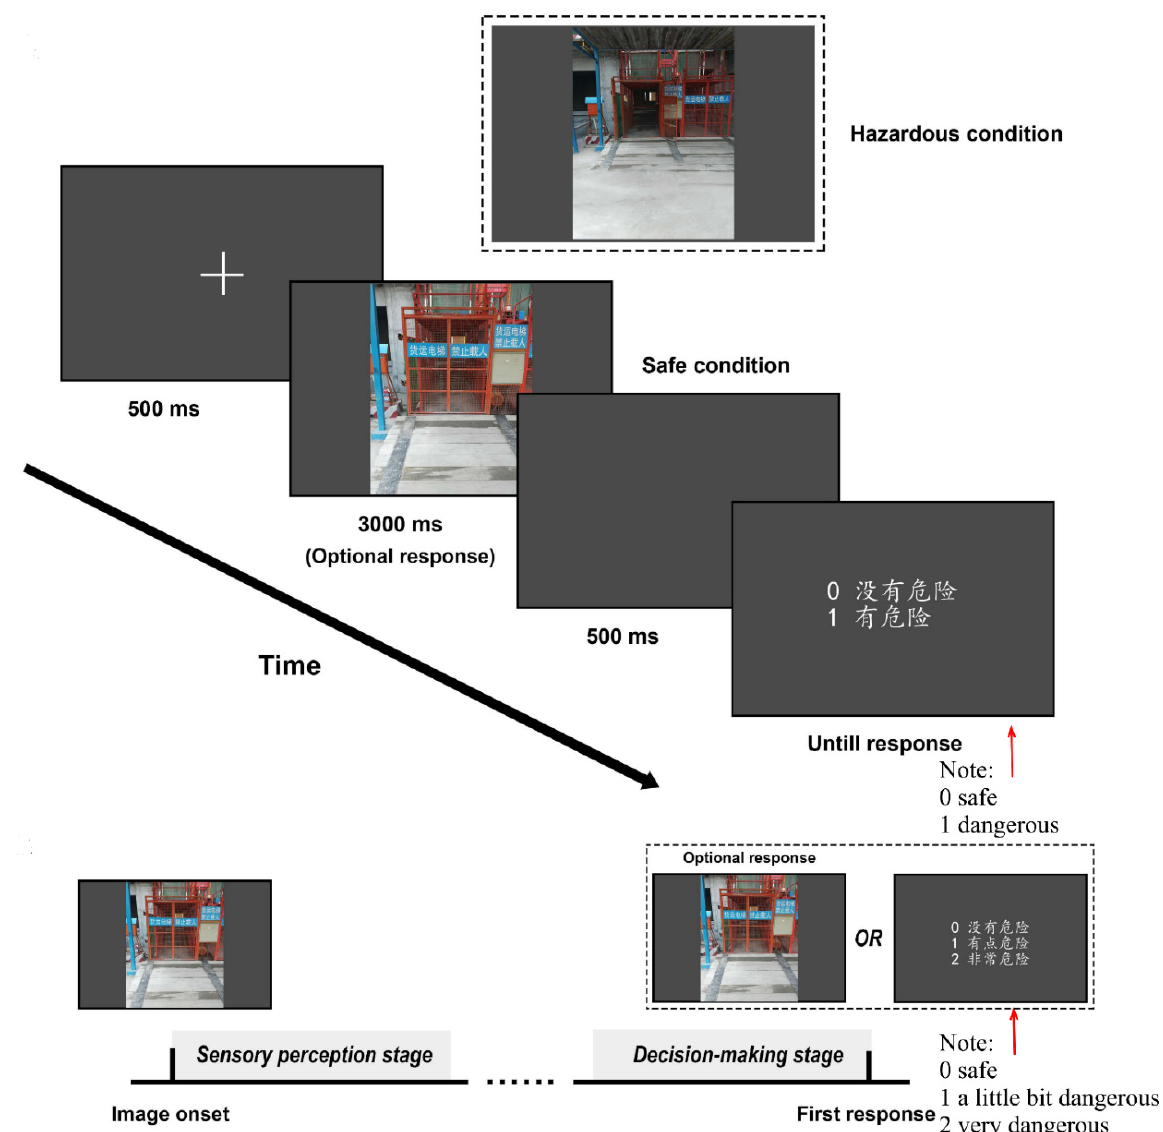
Figure 2. Experimental design. Note: The direction of the arrow represents the experimental flow. For specific experimental procedures, please refer to the first paragraph of Section 3.2.1.